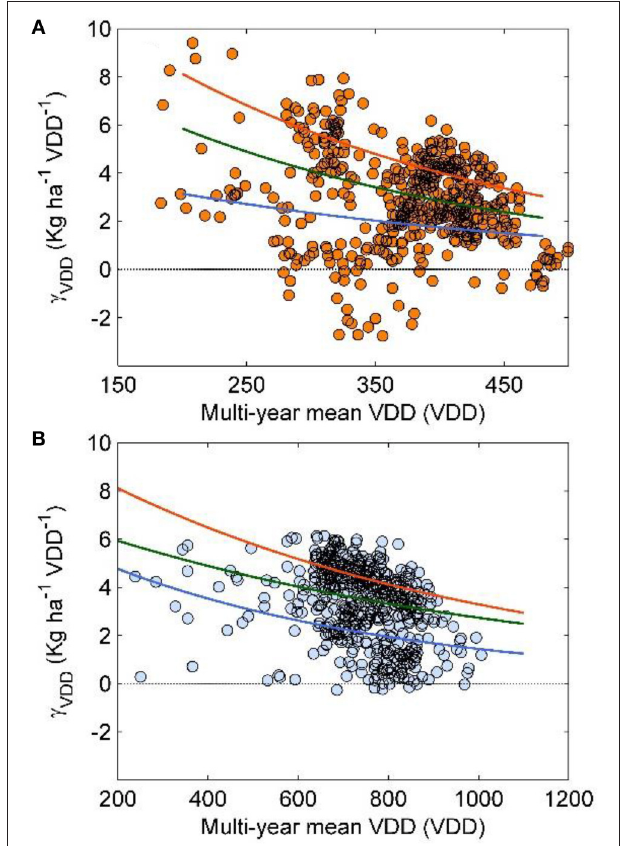
FIGURE 3 | Relationship between multi-year mean vernalization degree days (VDD) and the corresponding sensitivity of winter wheat yields to VDD during 1975–2009 in all croplands of temperate Europe (TE). The orange and blue circles in (A,B) represent spatial relationship between γ VDD and multi-year mean VDD for two different VDD calculations based on function in SIMTAG and ORCHIDEE_crop, respectively, in all grids (including grids without significant fitted multivariate linear regressions) in TE. The orange, dark green and blue lines in (A) are 75th, 50th, and 25th quantile negative exponential regression lines for the spatial